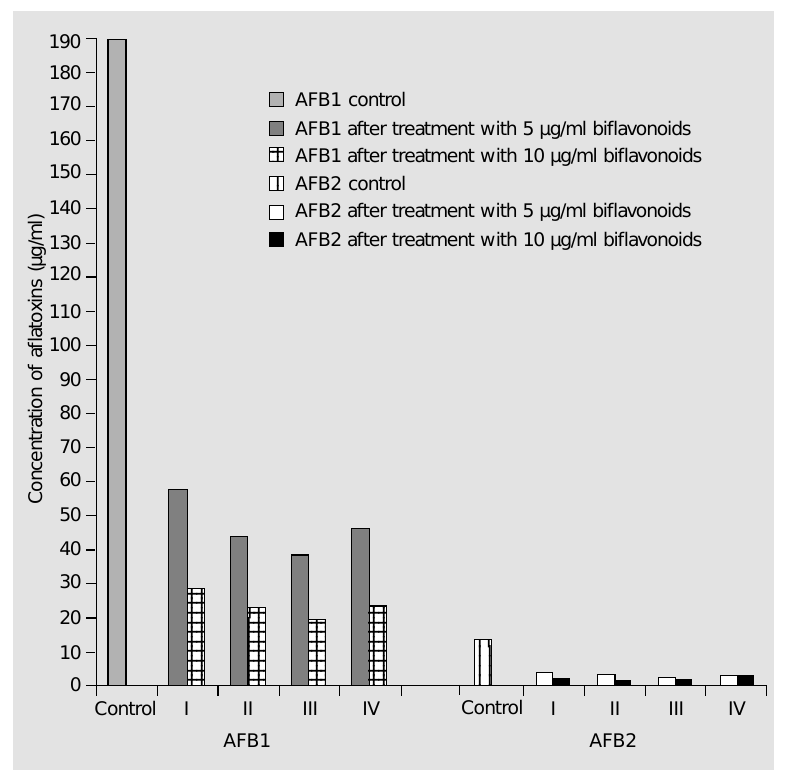
Figure 2. Production of aflatoxin B1 and B2 (AFB1 and AFB2, respectively) by Aspergillus flavus (IMI 190) cultures after treatment with different concentrations (5, 10 µg/ml and control) of the biflavonoids 6,6"-bigenkwanin (I), tetradimethoxybigenkwanin (II), amentho- flavone (III), and 7,7"-dimethoxyagastisflavone (IV). Three replicates were performed for each dilution. The four biflavonoids showed inhibitory activity on AFB1 and AFB2 produc- tion (P<0.001). The A. flavus used with control produced 188.6 µg/ml of AFB1 and 12.58 µg/ ml of AFB2 while the fungus treated with biflavonoids I, II, III and IV at 5 µg/ml concentra- tion produced 56.58, 42.65, 37.42 and 45.19 µg/ml of AFB1, respectively, and 2.38, 2.87, 1.88 and 3.17 µg/ml of AFB2, respectively. At 10 µg/ml concentration, the results obtained were 22.58, 22.29, 18.41 and 27.56 µg/ml of AFB1 and 2.34, 0.75, 1.11 and 1.55 µg/ml of AFB2 for compounds I, II, III and